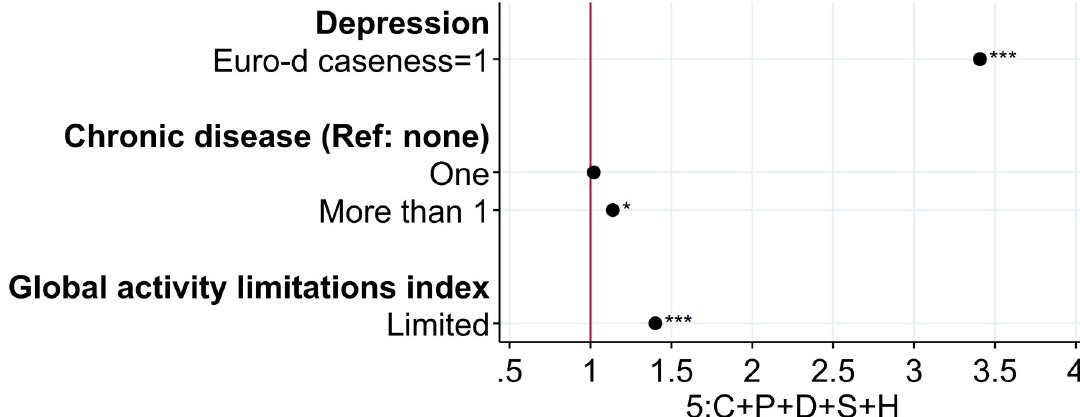
Fig 5. Loneliness at age 50+: The role of health. Note: The figure displays odds ratios of individual health information at age 50+ for the full specification. Specification (5) includes H, a vector of individual health information at age 50+; S, social support, activities, and network variables at age 50+; D, a set of individual socioeconomic and demographic variables at age 50+; P, a vector of the five scores of personality traits (extraversion, agreeableness, conscientiousness, neuroticism, openness); C, a vector of childhood circumstances (wealth; health; quality of the relationship with mother, father, and friends; importance of religion); and I, country-specific fixed effects. Reading example: in the full specification, having limitation with daily activities increases the odds of loneliness by 1.40. The pseudo R 2 and the proportion of correctly specified outcomes are respectively for each specification: (1): 0.0364; 82.89%, (2): 0.0600; 82.99%, (3): 0.0864; 82.96%; (4): 0.1181; 83.39%, (5): 0.1699; 84.09%. � p < 0.05, �� p < 0.01, ��� p < 0.001.